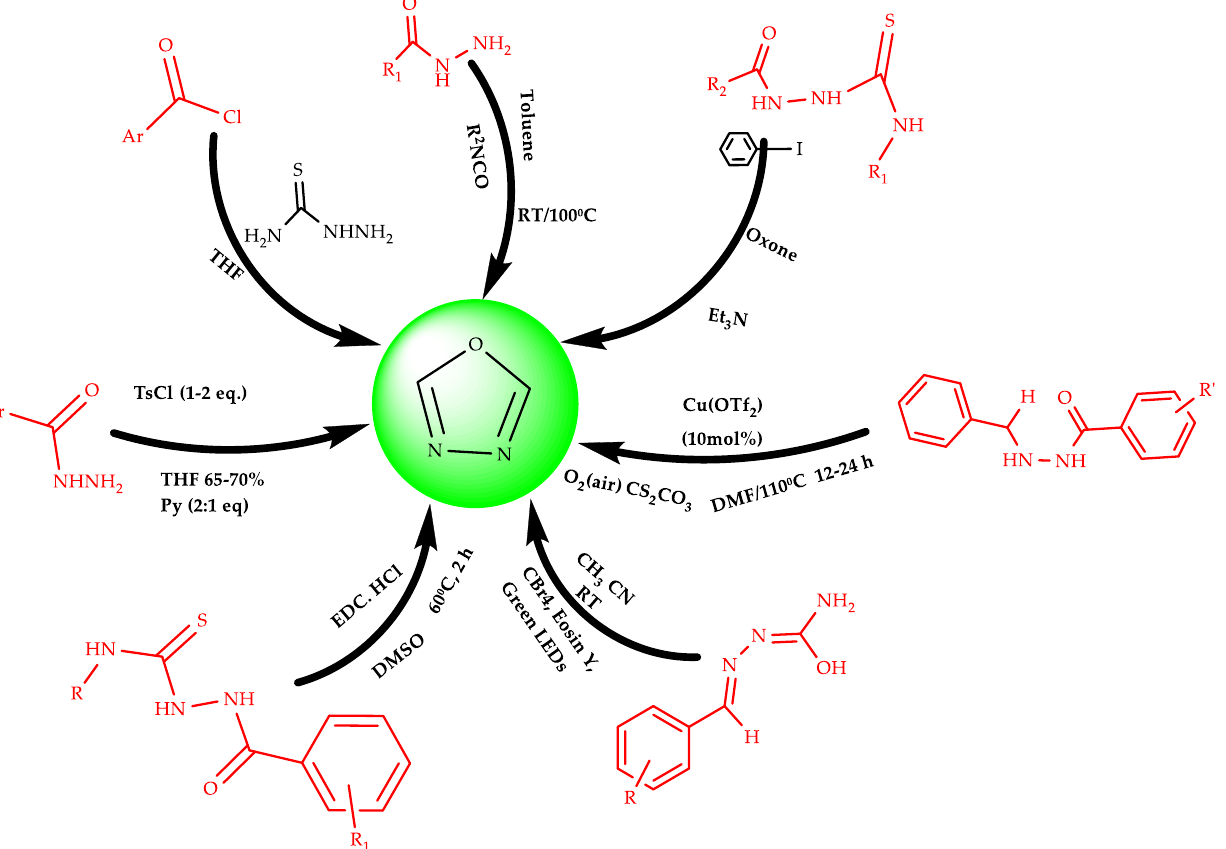
Figure 6. Various synthetic approaches for 1,3,4-oxadiazole derivatives .